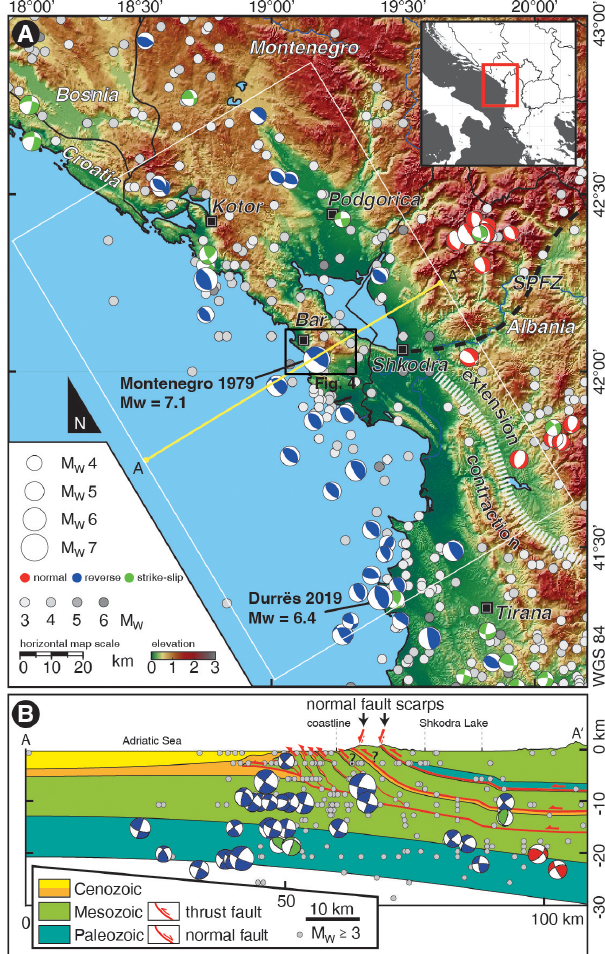
Figure 1. (a) Earthquakes in the study area: where available, fault plane solutions (FPSs) are scaled and color-coded according to magnitude and stress regime. All other earthquakes are color-coded by grey scales according to magnitude. SPFZ: Shkodra–Peja fault zone. (b) FPS projected onto profile A-A (cid:48) within the range of the white box (Fig. 1a). FPS from EMSC, EMRCMT and Harvard cat- alogues, Pondrelli et al. (2006), and Grünthal et al.